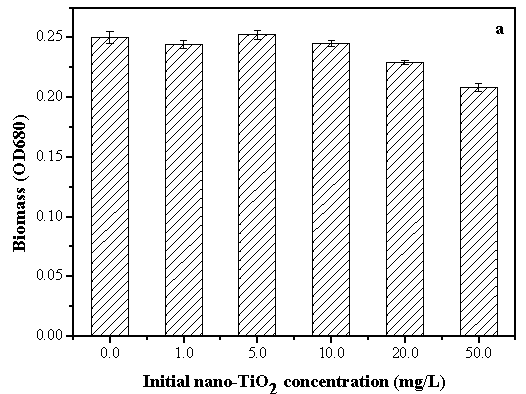
of algae at different initial level of nano-TiO ; ( c ) Photosynthetic yield of algae at different initial level of nano-TiO 2